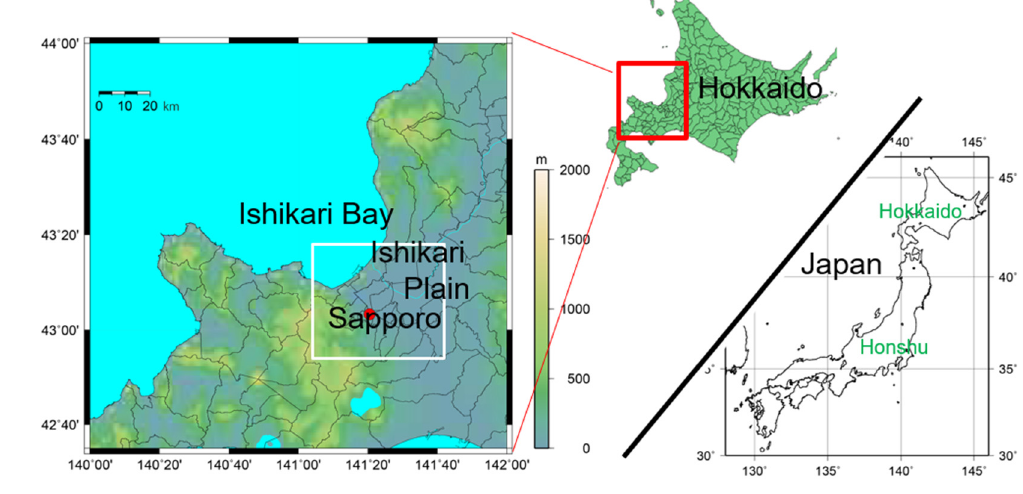
Figure 1. Geographic distribution of Hokkaido and area of interest. A red rectangle indicates the domain of the left panel, and a white rectangle indicates the target area shown in Figures 2b and 3. (The left panel was created by processing an electronic topographic map by the Geospatial Information Authority of Japan).